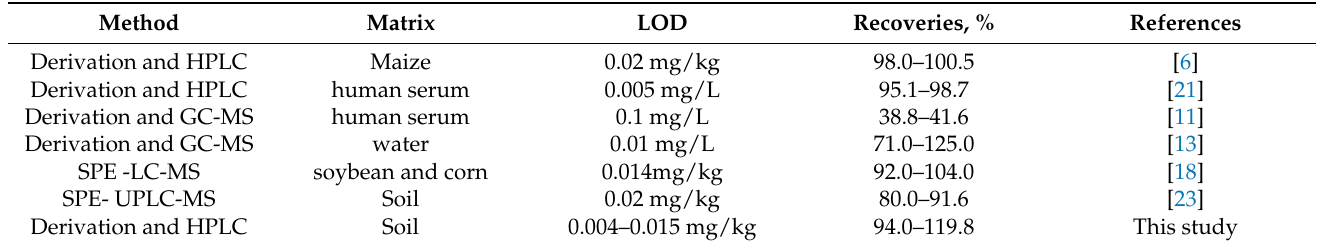
Table 5. Determination performance data of GLUF-P in different matrix by different